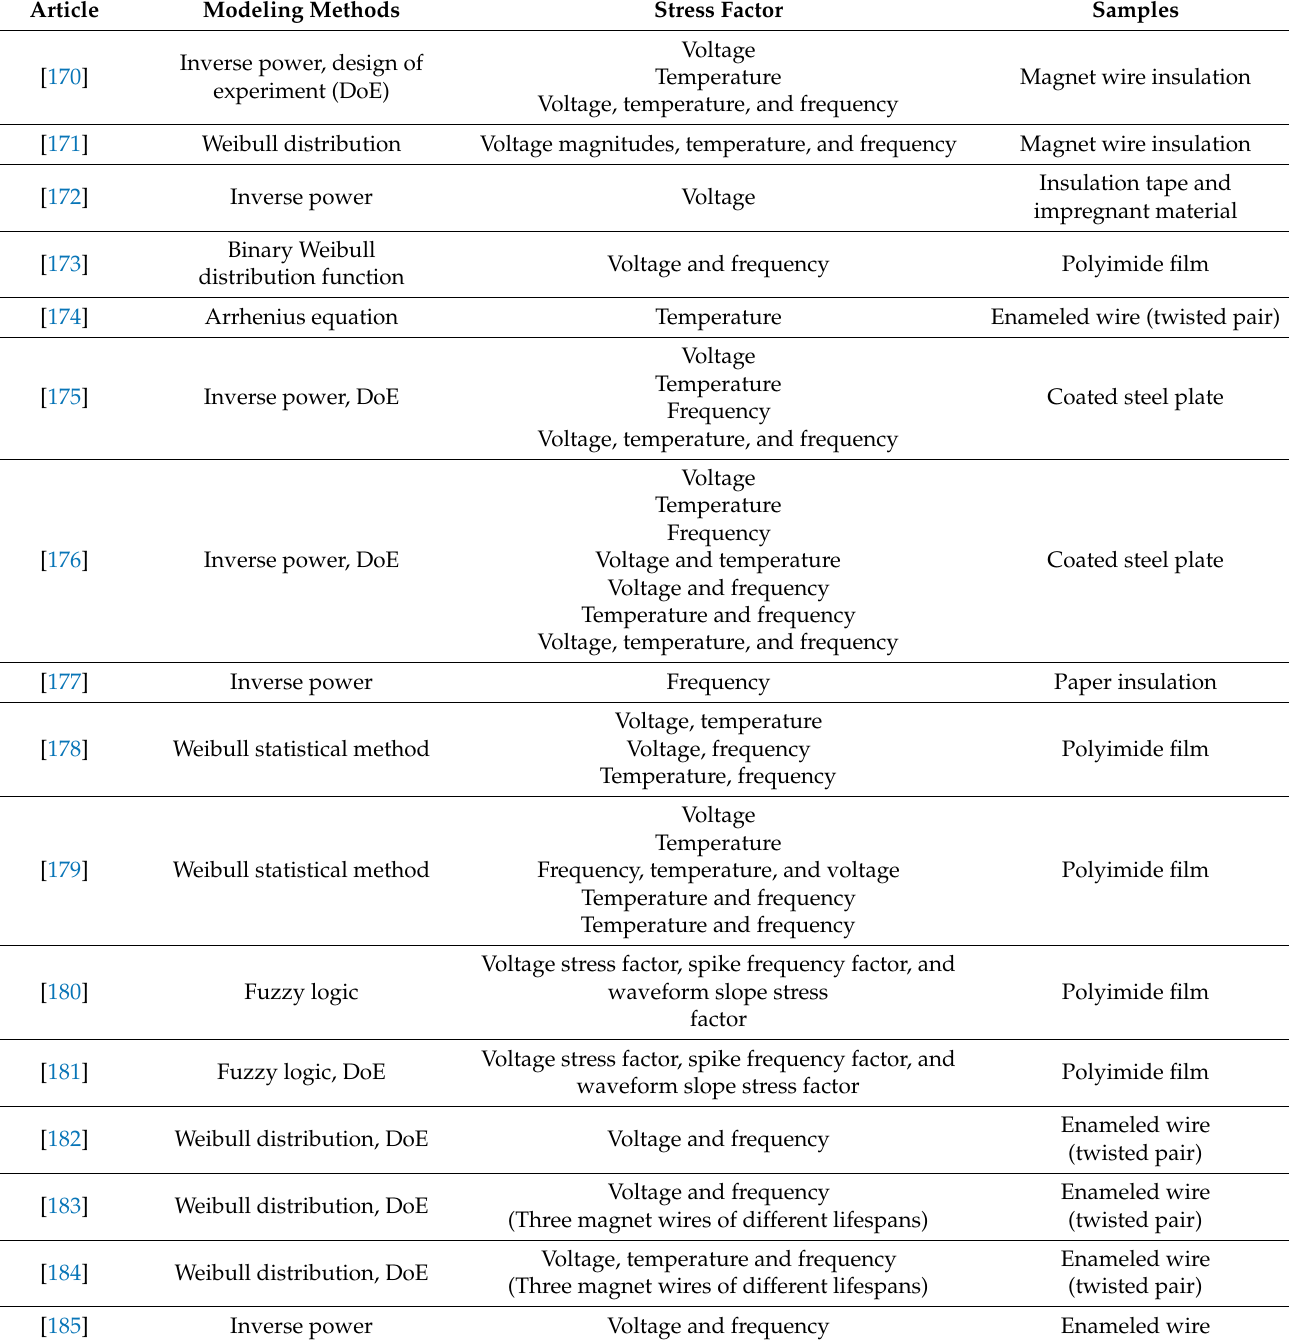
Table 7. Tools, stress factors, and types of samples in each